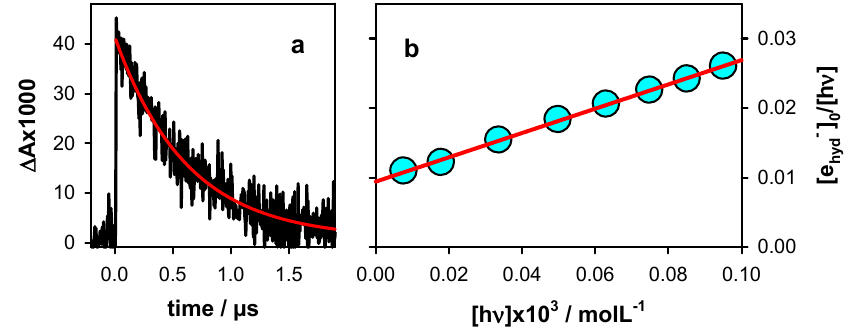
Figure 2. Hydrated electrons stemming from photo-ionization of TEL21/K + . ( a ) Transient absorption signal recorded at 700 nm with an incident excitation intensity of 1.7 × 10 6 Wcm − 2 . ( b ) Ionization curve; [e hyd − ] 0 and [h ν ] denote, respectively, the zero-time concentration of hydrated ejected electrons and the concentration of absorbed photons per laser pulse. Red lines represent fits with ( a ) a mono-exponential A 0 + A 1 exp( − t/ τ 1 ) and ( b ) a linear [e hyd − ] 0 /[h ν ] = φ 1 + α [h ν ] model function.